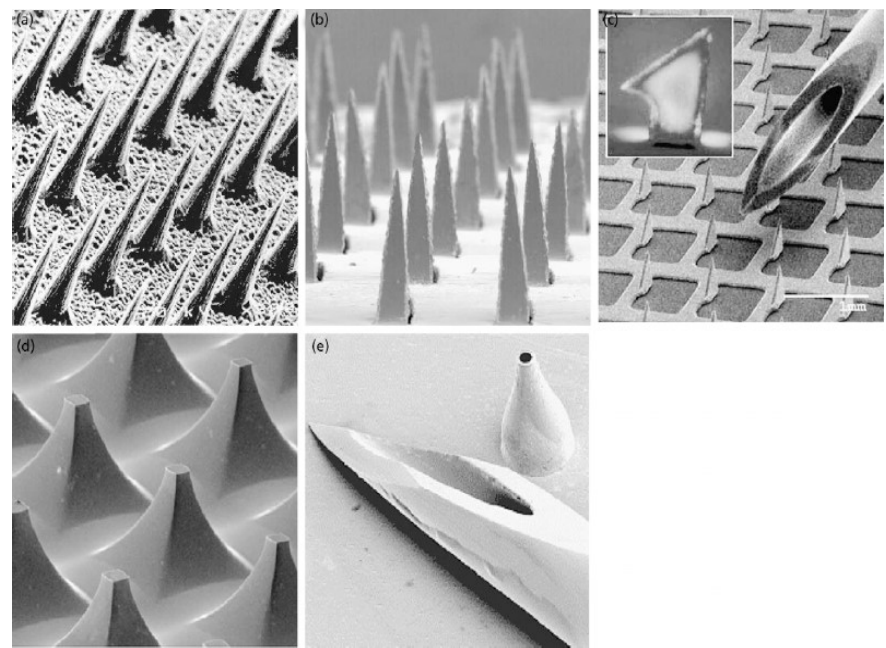
Figure 1. Types of microneedles used for transdermal drug delivery. ( a ) solid microneedles ionically etched from silicon wafer, ( b ) solid microneedles laser cut from stainless steel, ( c ) solid microneedles acid-etched from titanium sheet, ( d ) solid microneedles chemically etched from silicon wafers, and ( e ) hollow microneedles formed by electrodeposition of metal on to a polymer. Reproduced with permission from [18] , copyright Elsevier 2004.